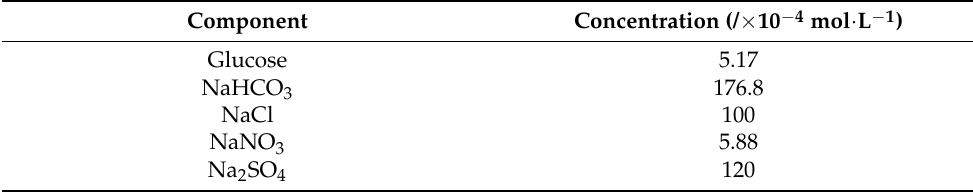
Table 1. Composition of simulated aqueous wastewater